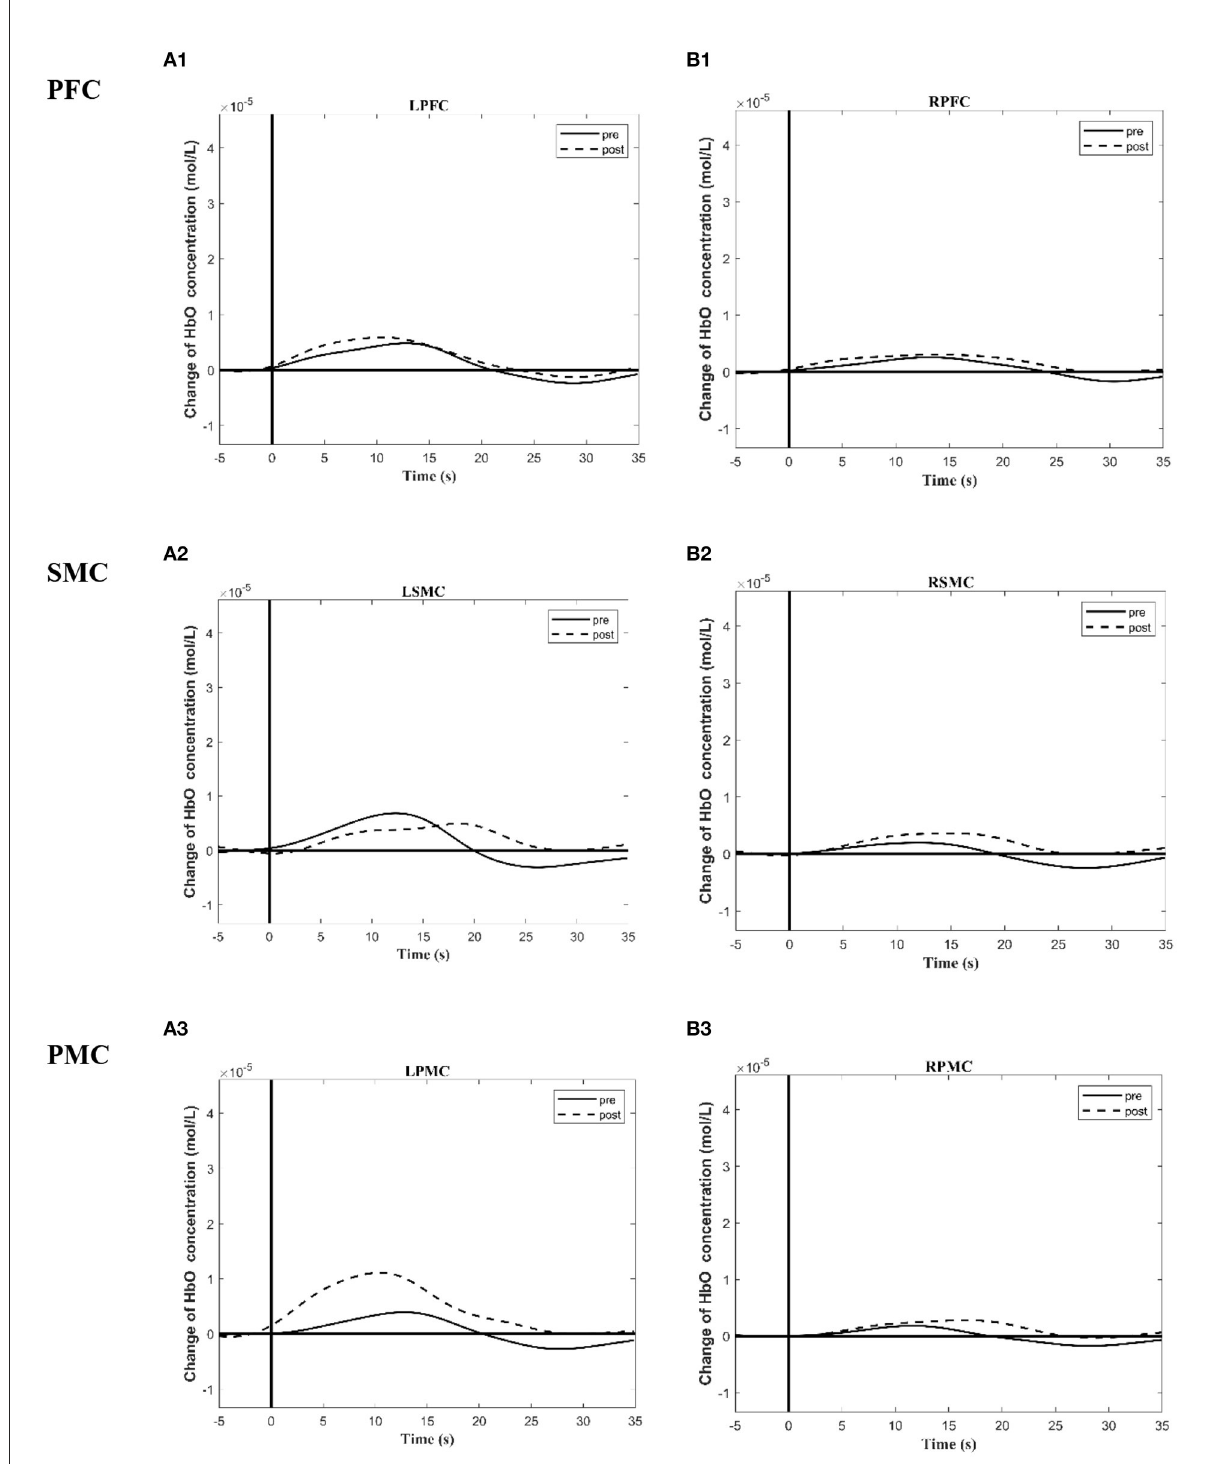
FIGURE4 Group time course maps of HbO concentration change during a motor task generated using the MATLAB HOMER toolbox pre and post the intervention. (A1–A3) Group activation time course maps of HbO concentration change on LPFC (A1) , LSMC (A2) , LPMC (A3) during grip-release task pre and post the intervention. (B1–B3) Group activation time course maps of HbO concentration change on RPFC (B1) , RSMC (B2) , and RPMC (B3) during grip-release task pre and post the intervention. The y-axis displays concentration changes of hemoglobin in moles per liter. The change of HbO concentration is indicated by solid line (pre intervention) and dotted line (post intervention). L (R)SMC, Left (Right)sensorimotor cortex; L (R)PMC, Left (Right)premotor cortex; Left (Right)PFC, Left (Right)prefrontal